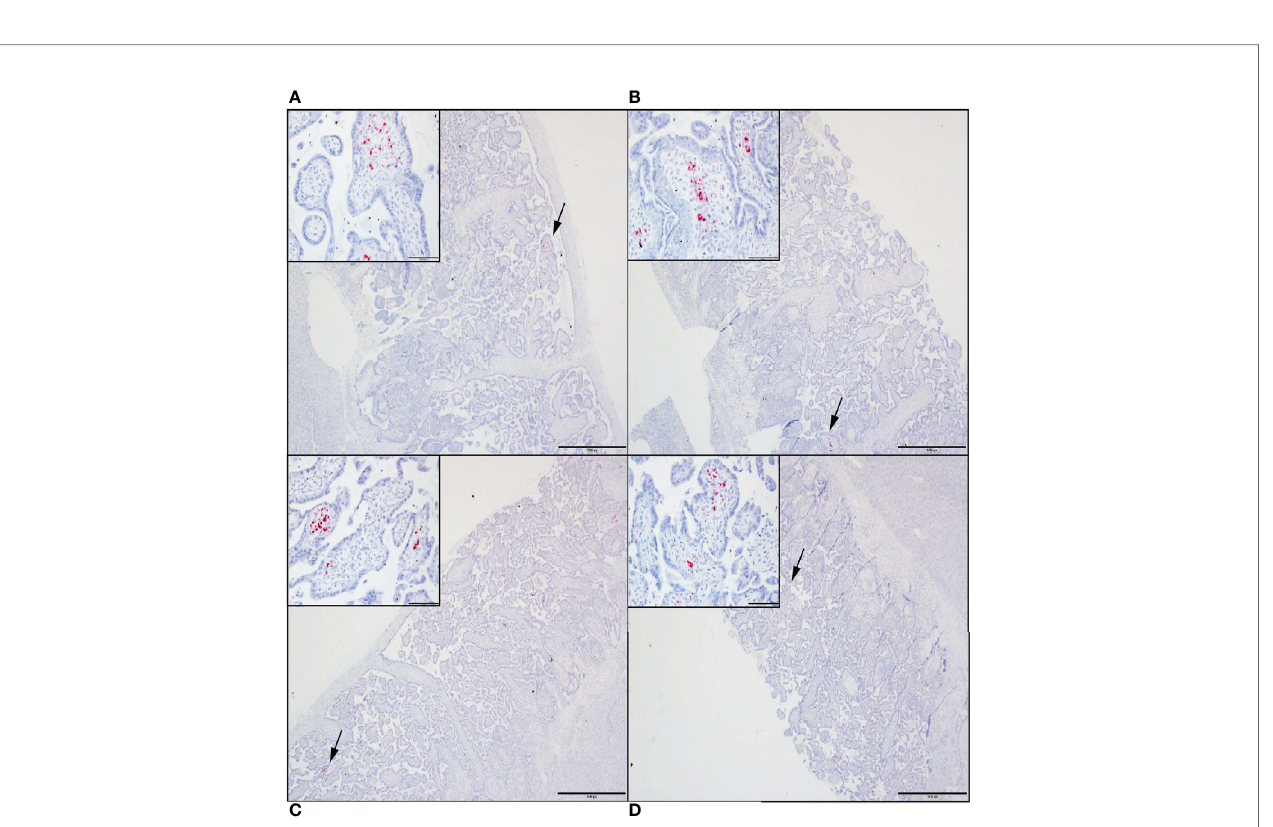
FIGURE 4 | ZIKV genomic RNA was detected by in situ hybridization (ISH) in placental tissues collected from dams 049-102 and 049-103, but not from dam 049- 101. For all images, red coloration is indicative of positive staining for ZIKV genomic RNA. Overall, positive staining is focal but visible in multiple areas. Insets show high magni fi cation of the areas denoted by the black arrows in each larger panel. Representative images are shown of (A) primary placental disk from 049-103, (B) secondary placental disk from 049-103, (C) primary placental disk from 049-102, and (D) secondary placental disk from 049-102. Scale bar = 1000